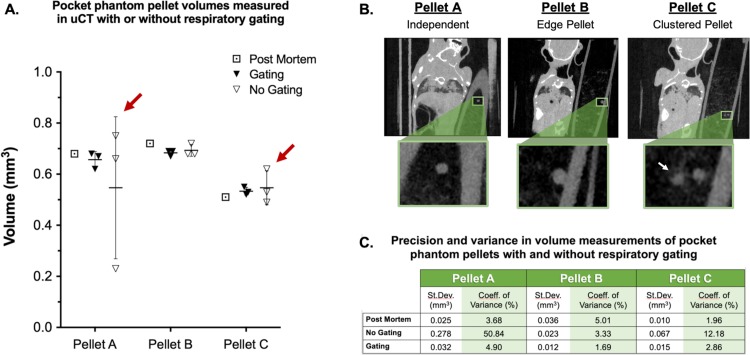
The effect of gating on volumetric output and measurement variance.Three pellets were measured three times in each acquisition condition, and volumes were calculated and compared to post-mortem measurements (A). Pellets were selected to mimic conditions regularly encountered during lung tumor analyses (B). Variance among measured volumes was greatest in non-gated images (red arrows in A), while gating resulted in precision similar to post-mortem measurements (C).